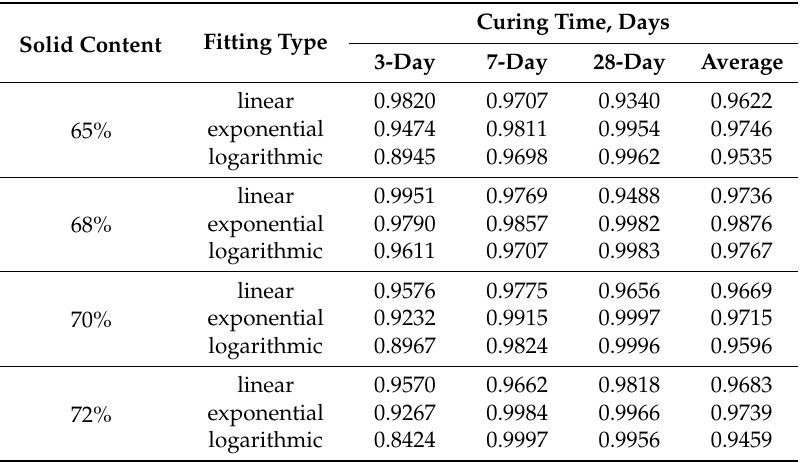
Table 9. UCS results of CTB samples under various c/t ratios.